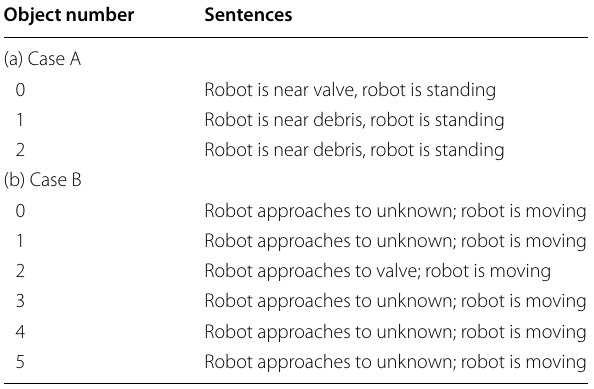
Table 11 Sentences created by LDA learning for Case A and Case B